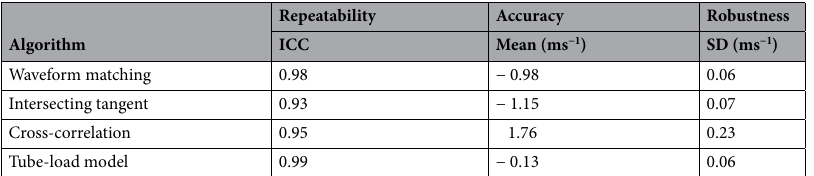
Table 7. Summary of the performance of four methods. Repeatability and robustness analyses were performed using the experimentally measured carotid and femoral pulse waveforms. Accuracy analysis was carried out using the carotid and femoral pressure pulse waves from the 1D